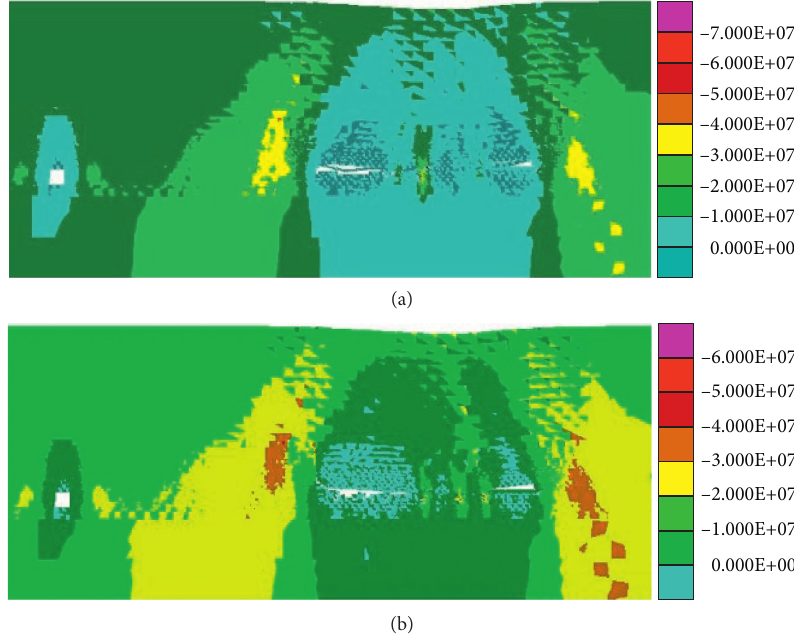
Figure 11: Vertical stress cloud on the surrounding rock. (a) No roof-cutting. (b) Roof-cutting.